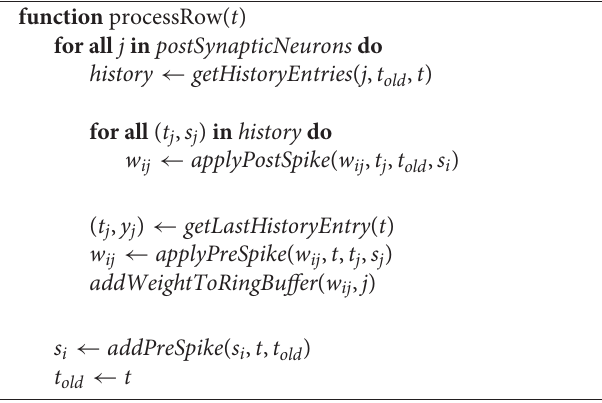
Algorithm 1 Algorithmic implementation of STDP (After Knight et al.,